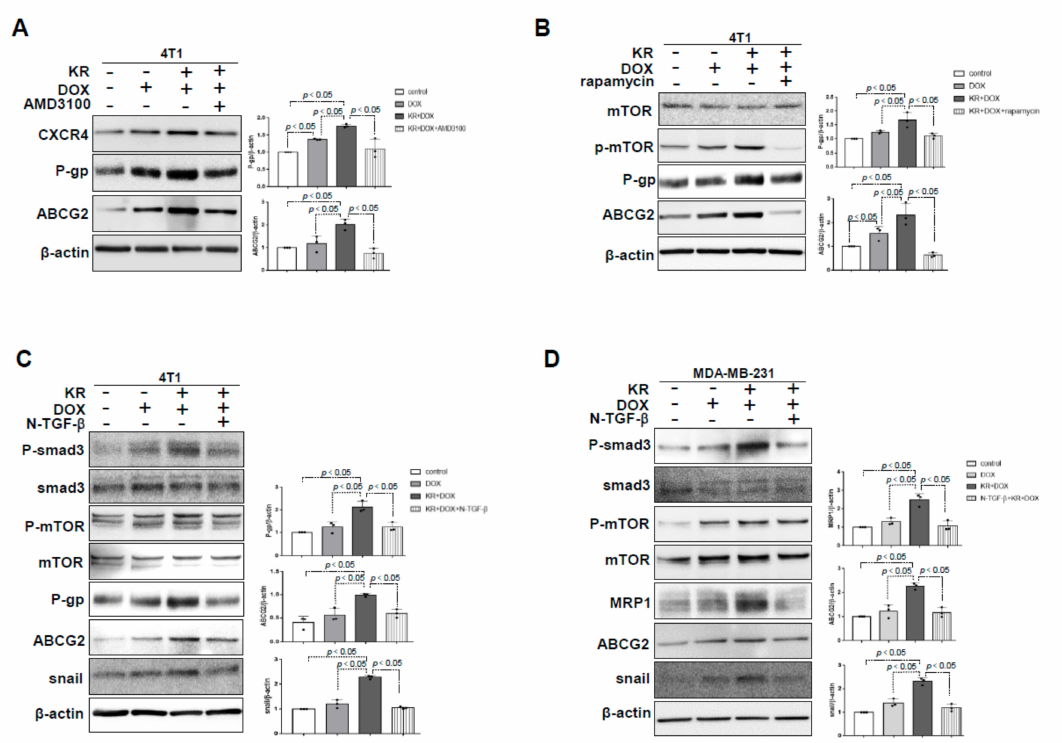
Figure 2. DPP-4 inhibition increased ABC transporters in combination with chemotherapeutic insult in a CXCL12 / CXCR4 / mTOR / TGF- β -dependent manner in breast cancer cells. ( A , B ) Western blot analysis of P-gp and ABCG2 in 4T1 cells pretreated with KR62436 (50 µ mol / L) for 48 h and then treated with DOX (0.425 µ mol / L) in the presence or absence of AMD3100 (30 µ mol / L) ( A ) and rapamycin (1 µ mol / L; B ) for another 48 h. ( C , D ) Western blot analysis of mTOR phosphorylation (P-mTOR), P-gp, ABCG2 and snail in 4T1 cells ( C ) and MDA- MB-231 cells ( D ) pretreated with KR62436 (50 µ mol / L) for 48 h and then treated with DOX (0.425 µ mol / L) in the presence or absence of a neutralizing TGF β (1, 2 and 3) antibody (N-TGF β , 1.0 µ g / mL) for another 48 h. All representative blots from three